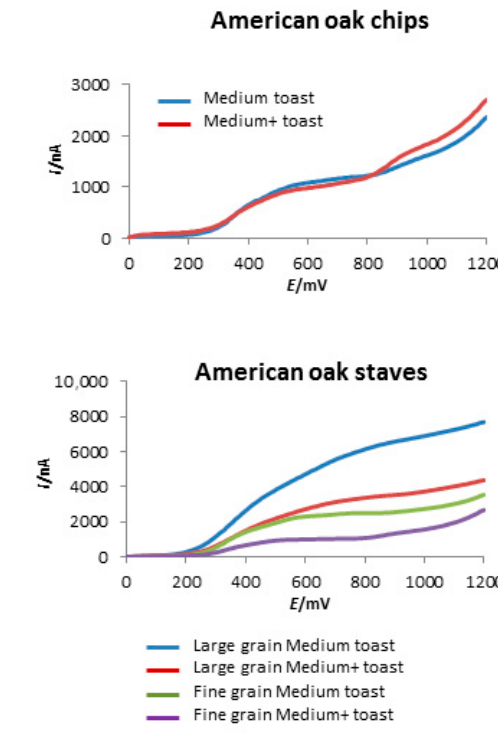
Figure 1. Linear sweep voltammograms of French and American oak chips and staves.